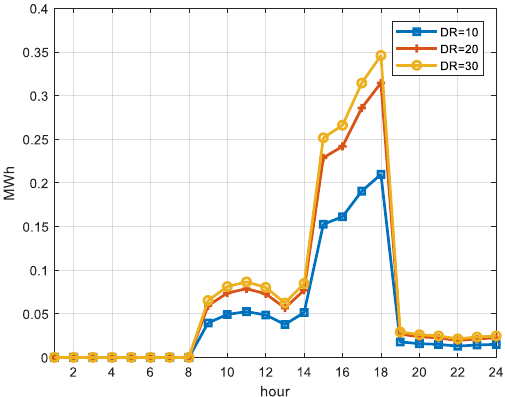
Figure 7. EENS under different DR marginal costs.